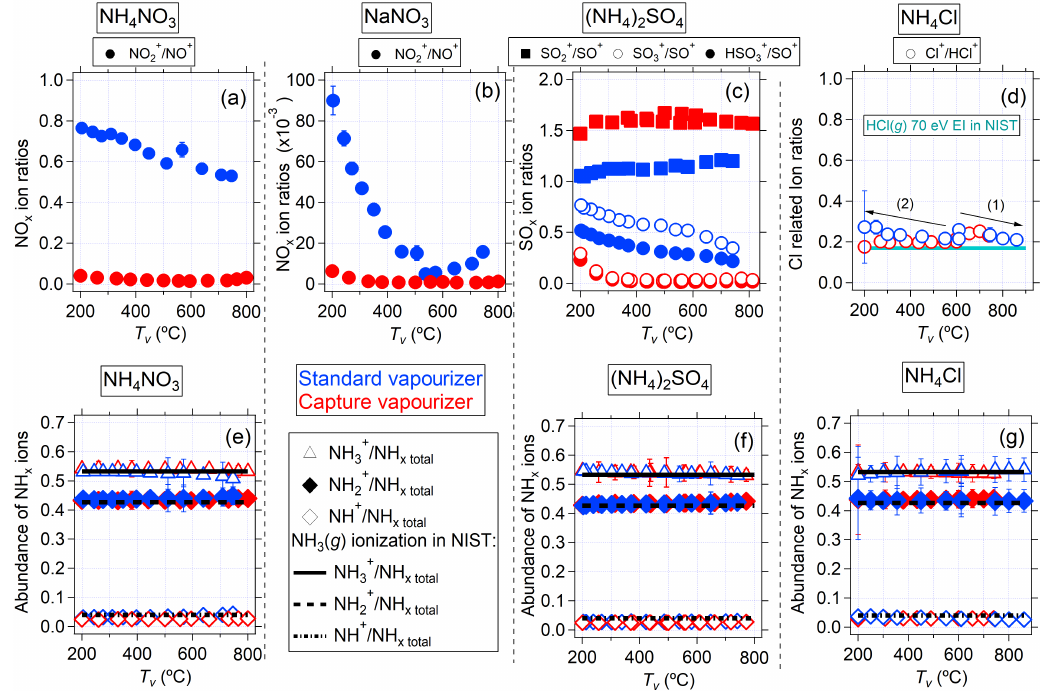
Figure 4. Ion ratios of pure inorganic standard species vs. T v for the SV and CV: (a) and (e) NH 4 NO 3 , (b) NaNO 3 , (c) and (f) (NH 4 ) 2 SO 4 , and (d) and (g) NH 4 Cl. Error bars are standard deviations. For the NH 4 Cl experiment, we first increased T v from 600 ◦ C (arrow labelled 1) in both the SV and CV, then turned it back to 600 ◦ C, and decreased the T v to 200 ◦ C (arrow 2).